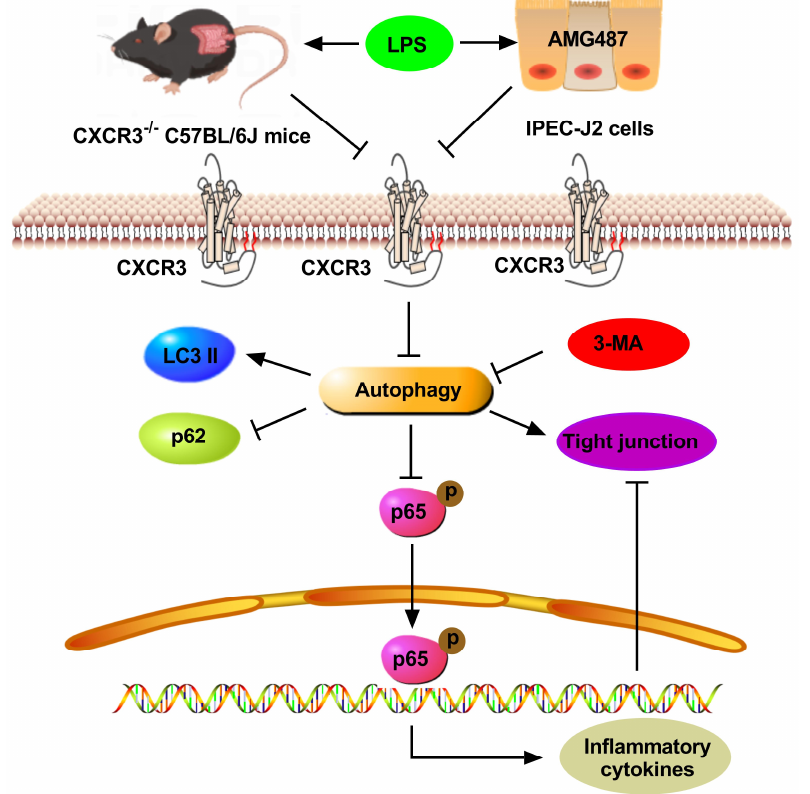
Figure 8. The schematic illustration of the underlying mechanism of CXCR3 inhibition-mediated autophagy alleviating inflammation and intestinal dysfunction. As a result, CXCR3 knockout and inhibition alleviate intestinal histological damage, increase tight junction expression, and restrain the NF-kB pathway in vitro and in vivo by autophagy elevation, which could be a therapeutic strategy by targeting CXCR3 against LPS-induced inflammation and intestinal dysfunction.